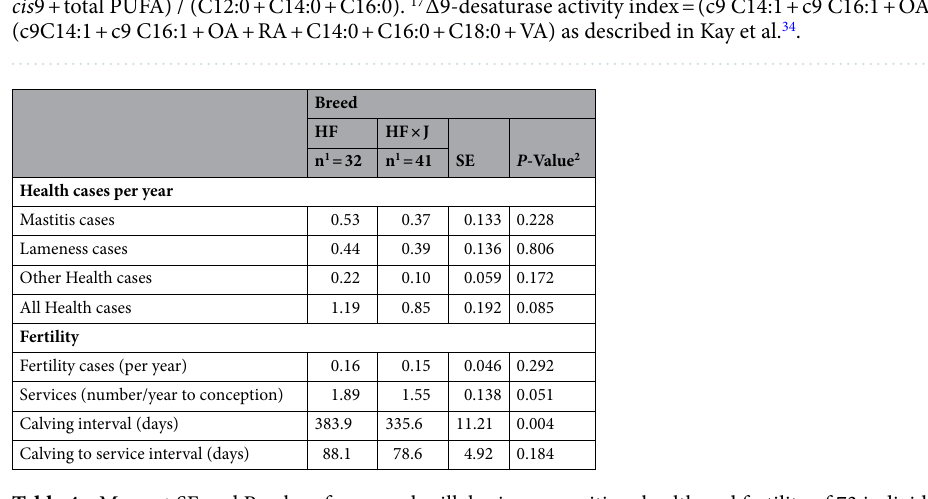
Table 4. Means ± SE and P-values for annual milk basic composition, health and fertility of 73 individual cows from two breeding groups (100% Holstein-Friesian, HF; 50% Holstein-Friesian:50% Jersey, HF × J) in four low- input dairy farms in England and Wales. 1 n is the number of records used to calculate means. 2 Significances were declared at P < 0.05.